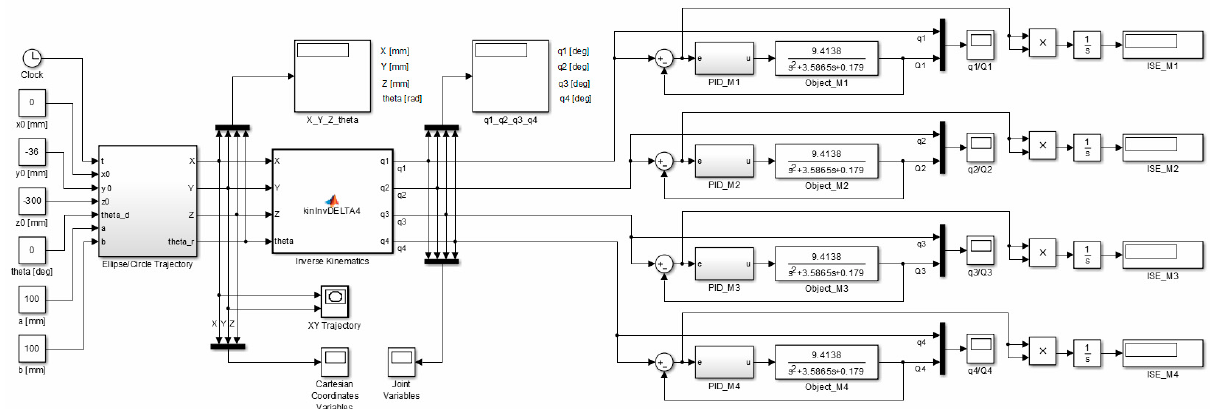
Figure 16. Simulation diagram of the manipulator control system in Matlab/Simulink. A circle with its center in the point (0, − 36, − 300) mm and a radius of 100 mm consti- tutes the set trajectory within the scope of tasks of the robot. The movable platform of the robot moves with a constant angular orientation of 0°. On the basis of the control devia- tion, an indicator (criterion) of the control quality in the form of ISE integral ( Integral Squared Error ) was calculated. Simulation time was 100 s with a constant sampling time of 0.01 s. The simulation results for the trajectory and the PID controller settings that were determined, are illustrated in Figures 17–21. Table 4 presents the designated values of the index of the control quality—ISE integral.